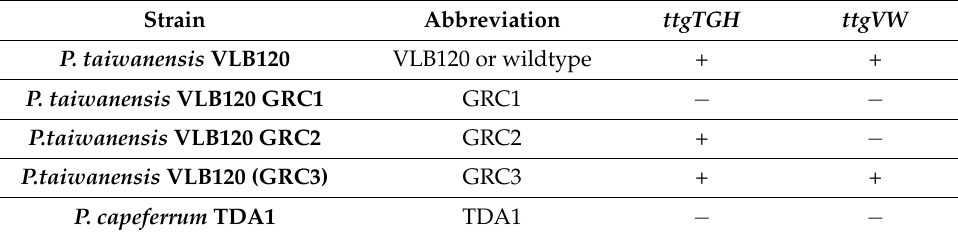
Table 1. Strains used in the study, their abbreviation, and the presence (+) or absence ( − ) of the full set of genes for the efflux pump TtgGHI and its regulators TtgVW. GRC: genome-reduced chassis, TDA: toluene